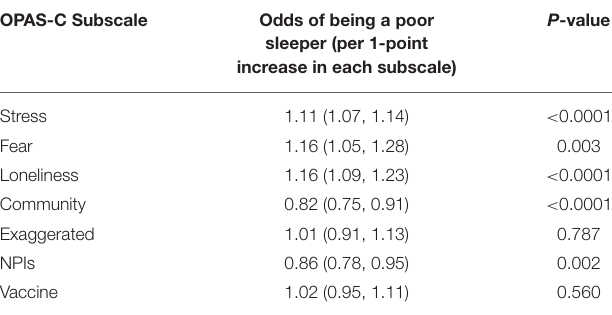
TABLE 4 | Association of individual OPAS-C subscale scores with the likelihood of being a poor sleeper (defined as PSQI > 5). OPAS-C Subscale Odds of being a poor sleeper (per 1-point increase in each